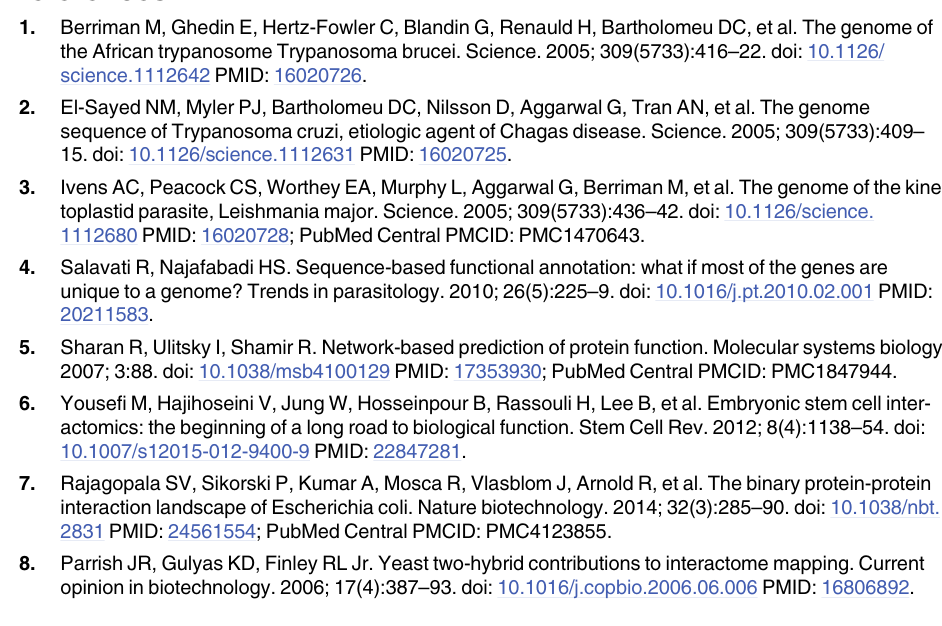
S2 Table. Co-fractionation networks introduced in this study. S3 Table. List of twenty complexes that were used to estimate the precision and recall of networks. S4 Table. TEV-elusion pull down of REL1 protein. S5 Table. Clustering results of TbGG-HC net. S6 Table. List of 50 proteins predicted to be associated with the RNA editing machinery. (XLSX) Fig